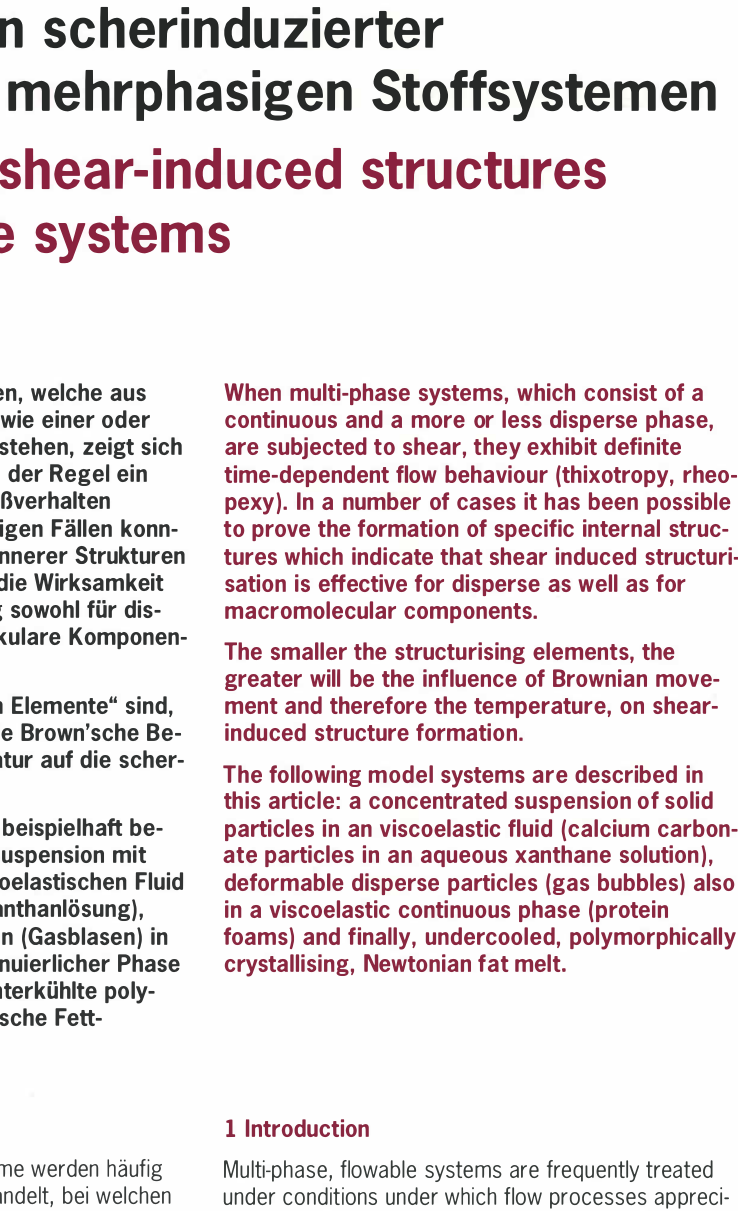
open symbols: up curves closed symbols: down